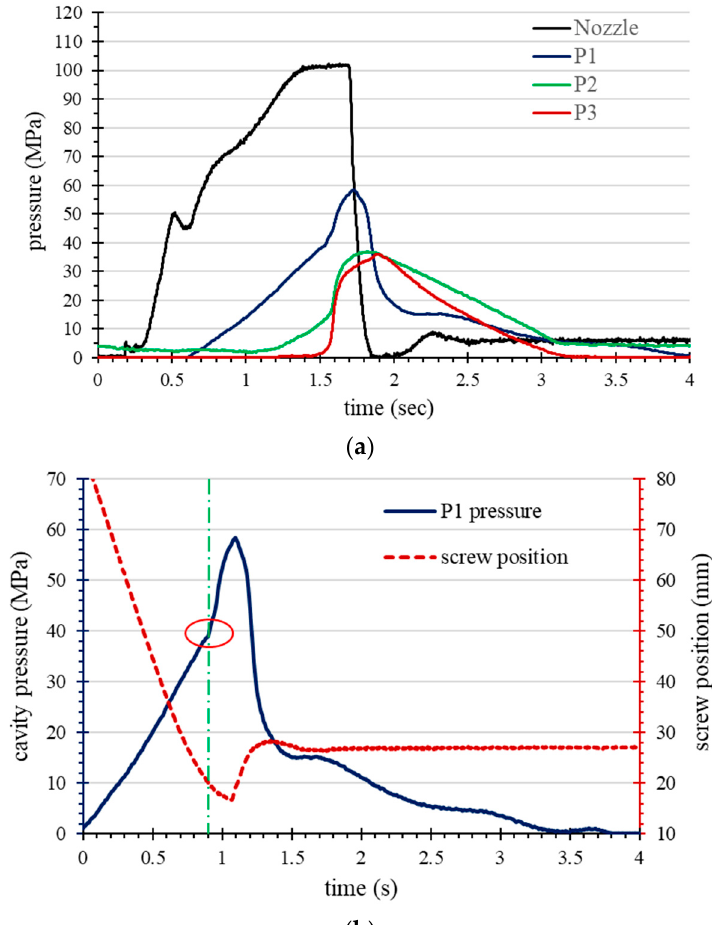
Figure 6. Cavity pressure profile and screw position with over-filling (no packing): ( a ) pressure profiles as the screw stroke acts on the fully filled cavity without packing; ( b ) the screw position of the completely filled cavity can be identified as about 17 mm.